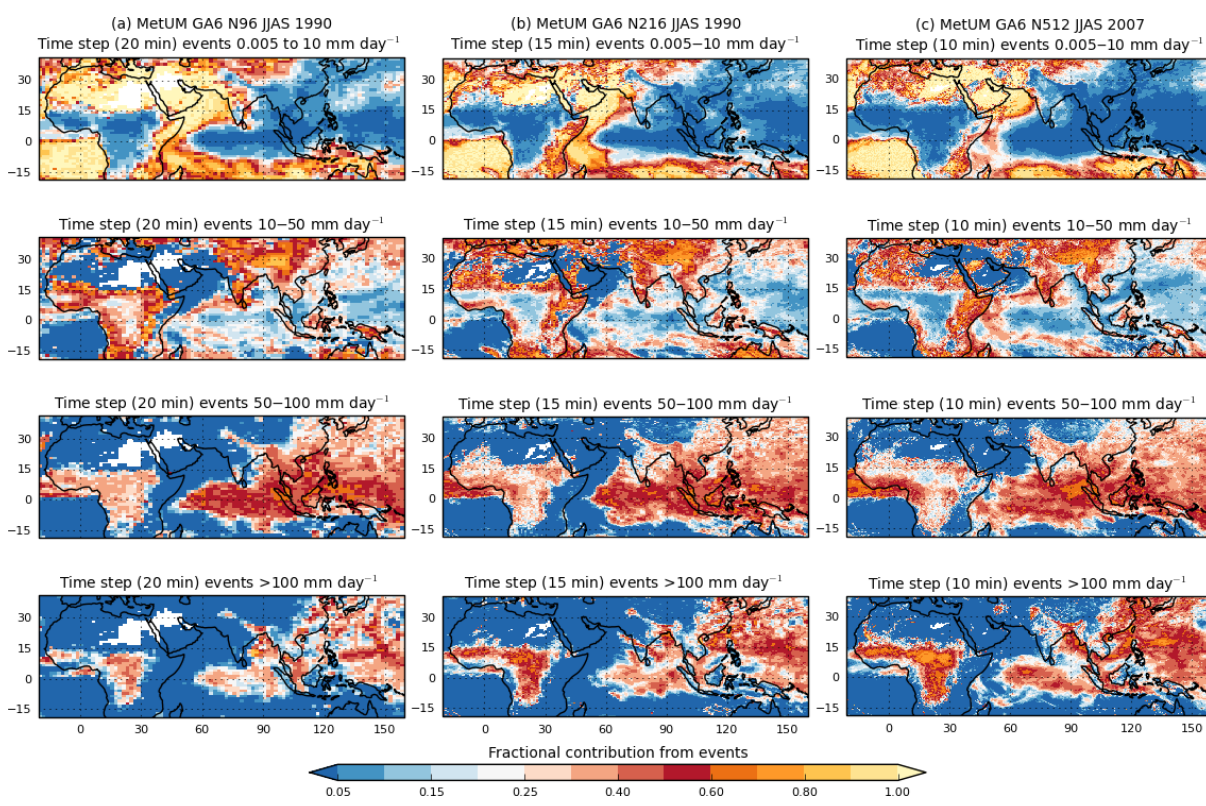
Figure 8. Spectral maps of time step precipitation in JJAS from three MetUM GA6 configurations: (a) N96, (b) N216 and (c) N512. Data are analysed on each configuration’s native grid. For each panel, the fractional contributions from all bins within the given intensity range are summed at each grid box. Time step lengths and years analysed are shown in Table